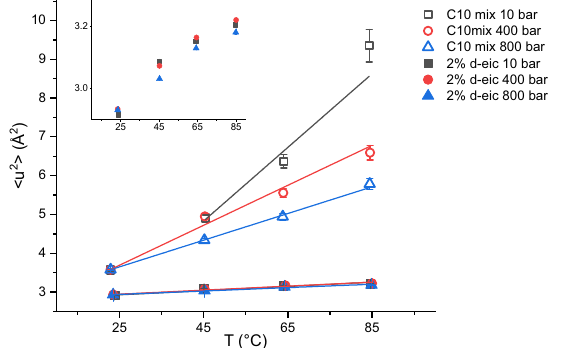
Fig. 4 Atomic mean square displacements. MSD for the two samples studied: C10 mix (empty symbols) and C10 mix with d-eicosane (full symbols). All lines are linear fi ts to the data. Note the clear dependence on temperature and pressure for the sample missing the eicosane, while all MSD values vary little at all T – p when the eicosane is added. The errors are calculated by propagation from I sum , as detailed in the main text. Inset: vertical zoom of the C10 mix + 2% d-eicosane